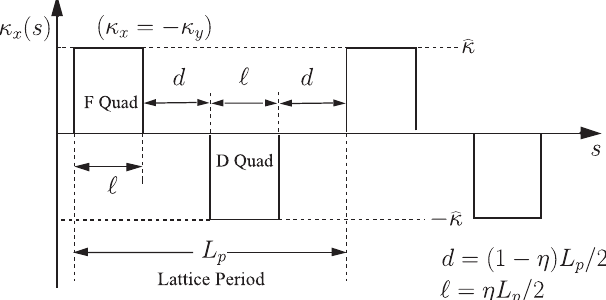
FIG. 1. Quadrupole FODO focusing lattice employed in illus- trative